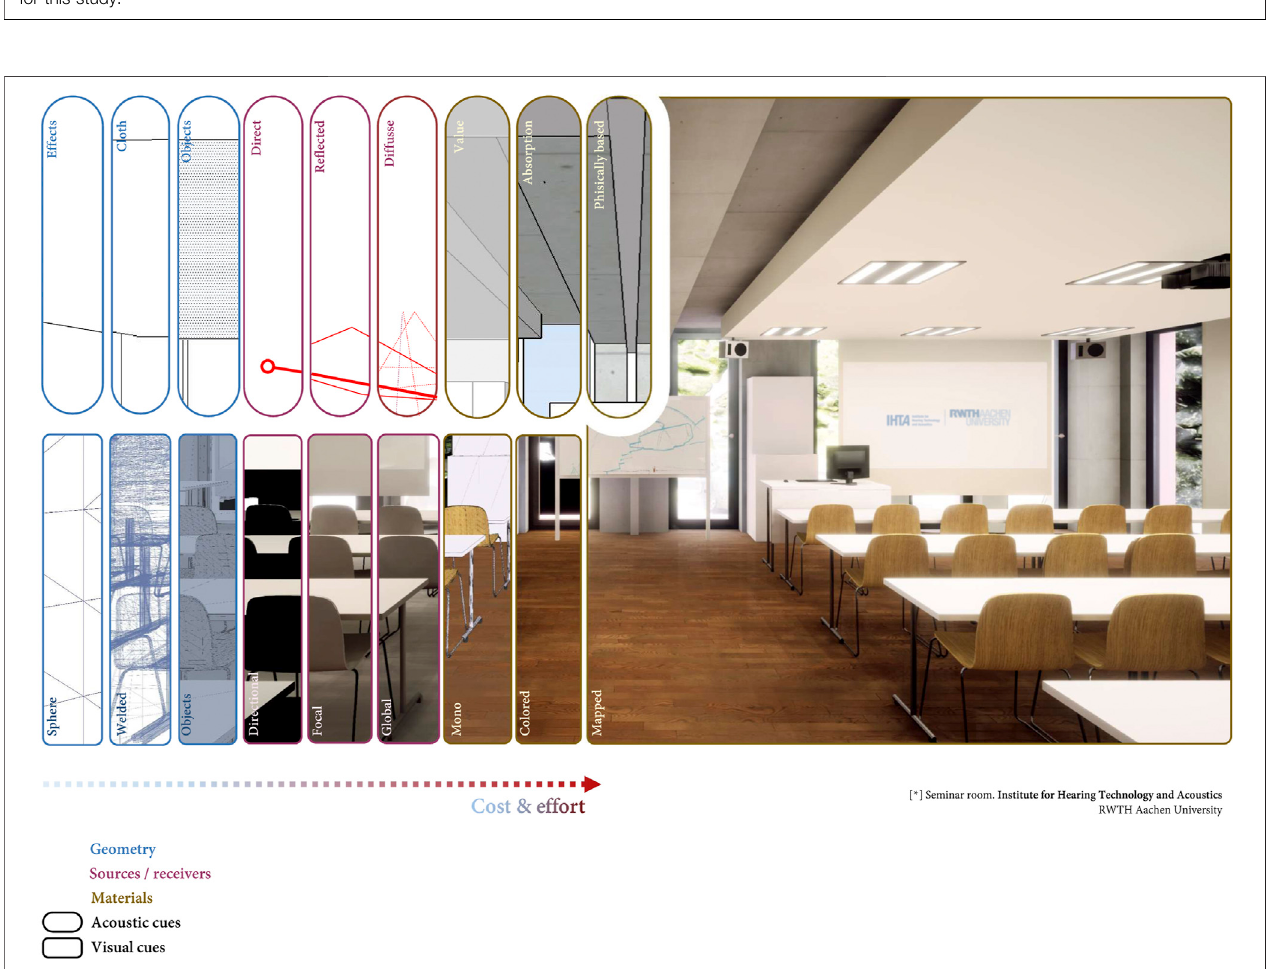
FIGURE 8 | The complete framework modules displayed for the demonstrator “ indoor classroom speech intelligibility ” as used in a usual modeling work fl ow. Geometry, sources, and receivers, and material de fi nitions are represented for each acoustic and visual cue. The order of them follows the common modeling and simulation work fl ow: geometry, basic lighting, material de fi nitions, and fi nal rendering, as well the cost and effort implied in the process. The same logic applies for outdoor scenarios.